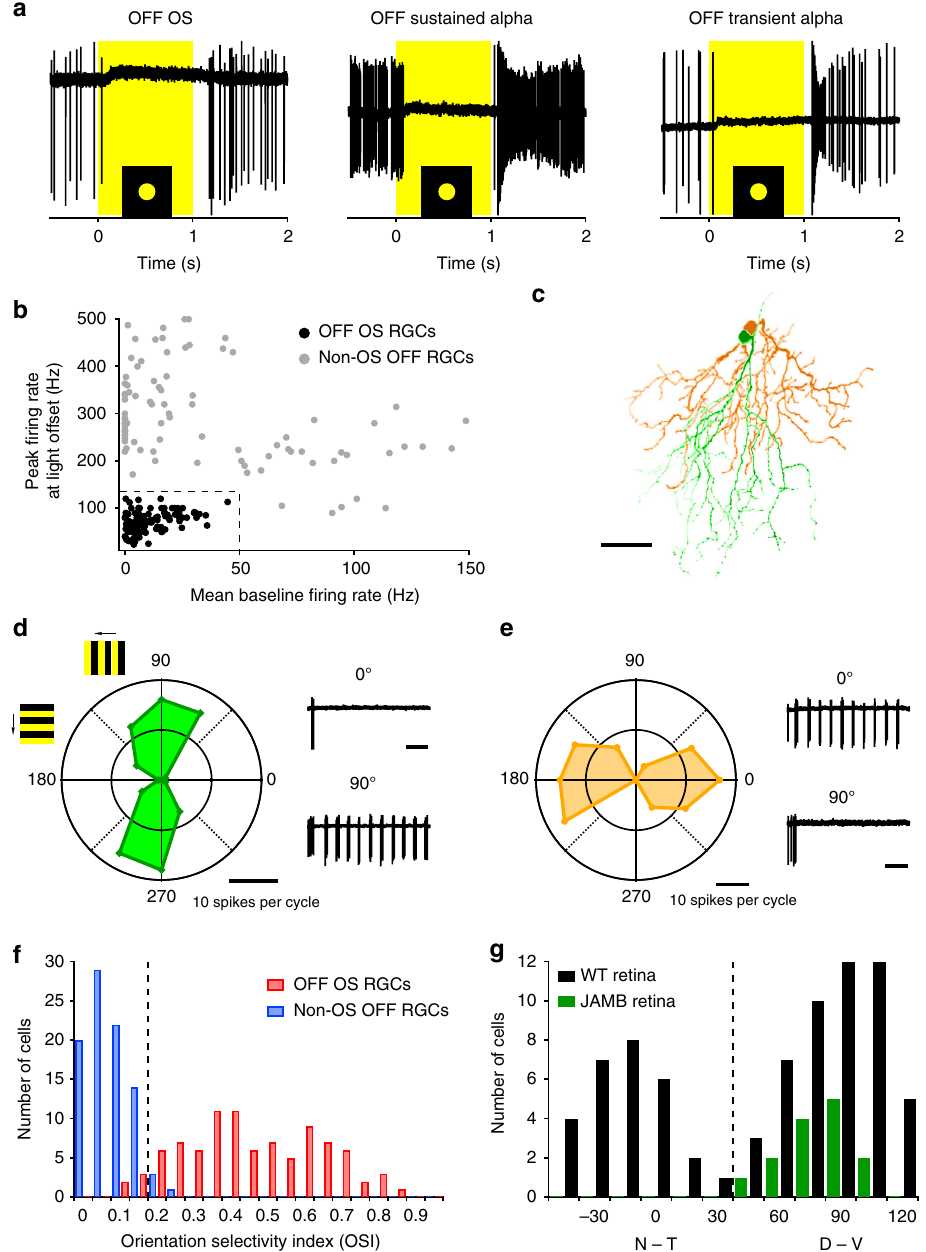
Fig. 1 OFF OS RGC is a distinct functional cell type. a Responses of OFF OS (left) OFF sustained alpha (middle) and OFF transient alpha (right) RGCs to a 1 s fl ash of 200 μ m diameter circular light spot from darkness. Yellow rectangle indicates light stimulus. b Peak fi ring rate at light offset plotted against mean baseline fi ring rate for OFF OS ( n = 92) and non-OS ( n = 84) RGCs. Dotted lines indicate peak fi ring rate = 135 Hz and mean baseline fi ring rate = 50 Hz. c Dendritic morphology of two neighbouring OFF OS RGCs. Scale bar = 50 μ m. d , e Polar plots of drifting grating responses of OFF OS RGCs coloured in green ( d ) and ( e ) orange, respectively. F1 response amplitudes and grating angles are plotted in radial axes and angle axes, respectively. F1 cycle average responses are calculated from three trails in each angle. f Histogram of OSI of OFF OS ( n = 92) and non-OS RGCs ( n = 84) as identi fi ed by their light step response pro fi le. Dotted line indicates OSI = 0.2. g Angle histogram of preferred orientations of OFF OS RGCs recorded in WT retina (black, n = 78) or labelled cells in the JAM-B line (green, n = 14). Dotted line indicates 45° dendrites pointing toward ventral retina (Fig. 2a). OFF hOS (http://www.museum.eyewire.org) 43 , we believe that the most likely RGCs displayed more symmetric dendritic morphologies than matches are type ‘ 2aw ’ for OFF vOS RGCs and type ‘ 2i ’ for OFF OFF vOS RGCs (Fig. 2b). However, we did encounter 2 of 22 hOS RGCs. OFF vOS RGC with symmetric dendrites. OFF vOS cells strati fi ed To quantify dendritic asymmetry, we fi t polygons to the distal to the OFF choline acetyltransferase (ChAT) band (Fig. 2c). dendritic trees and calculated the area and the centre of OFF hOS RGCs strati fi ed in similar locations (Fig. 2d; p = 0.56, mass (COM) of the arborizations. OFF vOS RGCs had larger Mann – Whitney U -test). Comparing our morphological measure- dendritic area than OFF hOS RGCs (4.48 ± 0.48 × 10 4 μ m 2 , n = 26 ments with an online database of mouse RGC morphologies